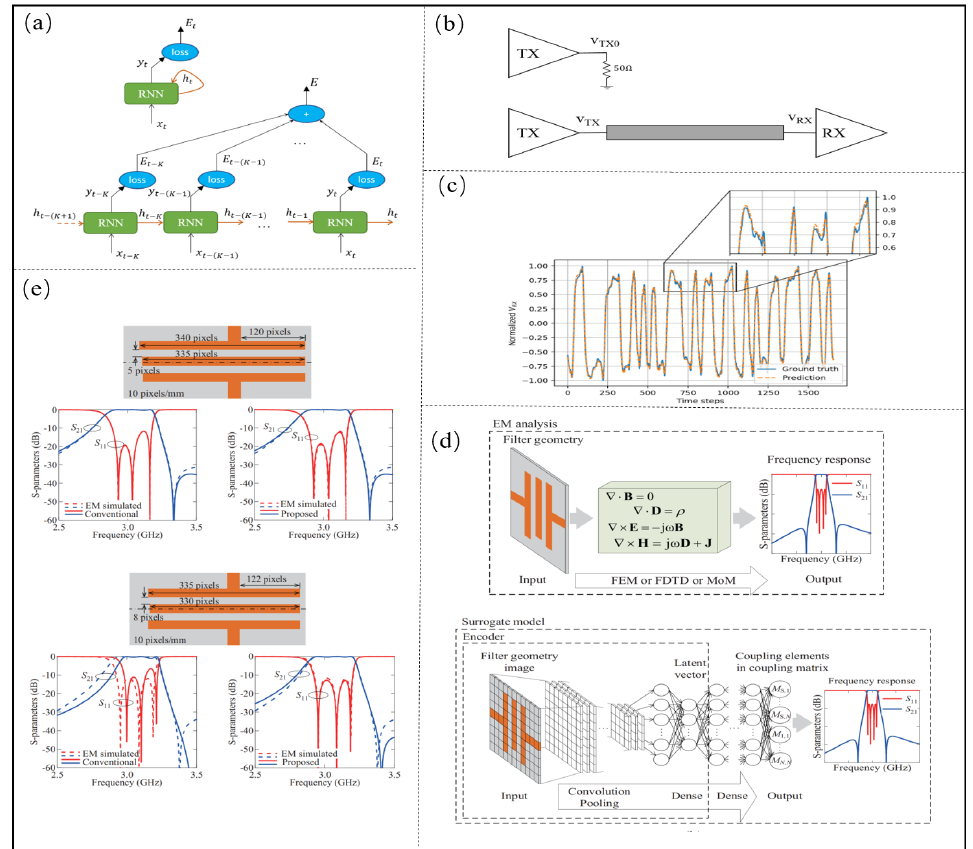
Figure 5. ( a ) Unrolled RNN with an input sequence of K steps. Adapted with permission from [71]. ( b ) PAM2 channel. Adapted with permission from [71]. ( c ) Predicted voltage at the receiver VRX with a LSTM network. Adapted with permission from [71]. ( d ) Proposed CAE-based CNN model. Adapted with permission from [73]. ( e ) The comparison results between the traditional CNN and the proposed convolutional encoder. Adapted with permission from